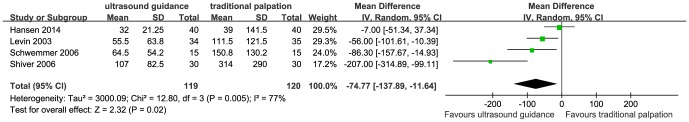
The forest plot depicting mean-time to success.